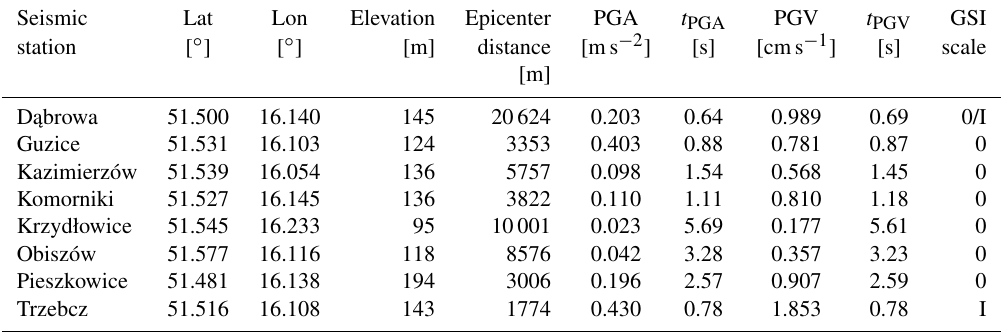
Table 2. IS-EPOS data on analyzed seismic constraints. Seismic intensity is defined based on peak ground acceleration (PGA), duration of peak ground acceleration ( t PGA ), peak ground velocity (PGV) and duration of peak ground velocity ( t PGV ) (Guzy, 2019). Seismic Lat Lon Elevation Epicenter PGA t PGA PGV GSI station distance D